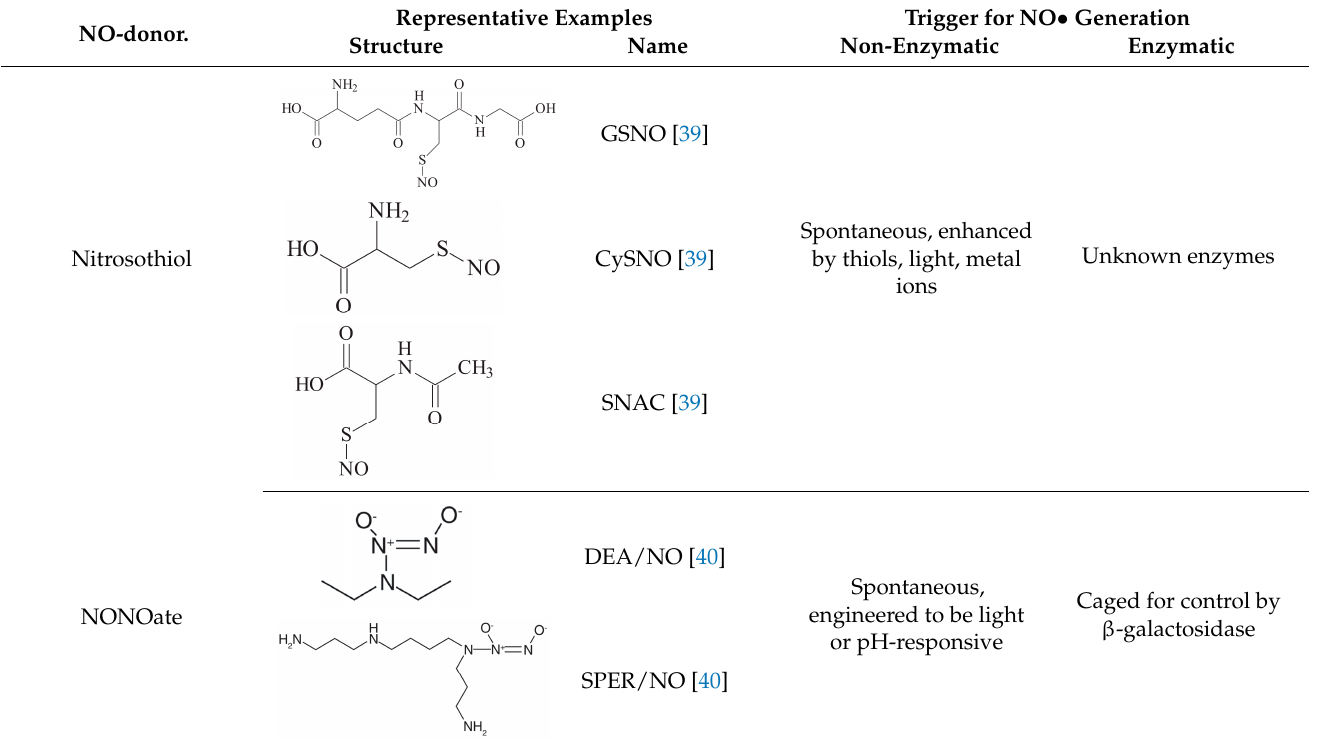
Table 1. Cont. Table 1. Representative NO-donors according to chemical class, adjusted from [33].